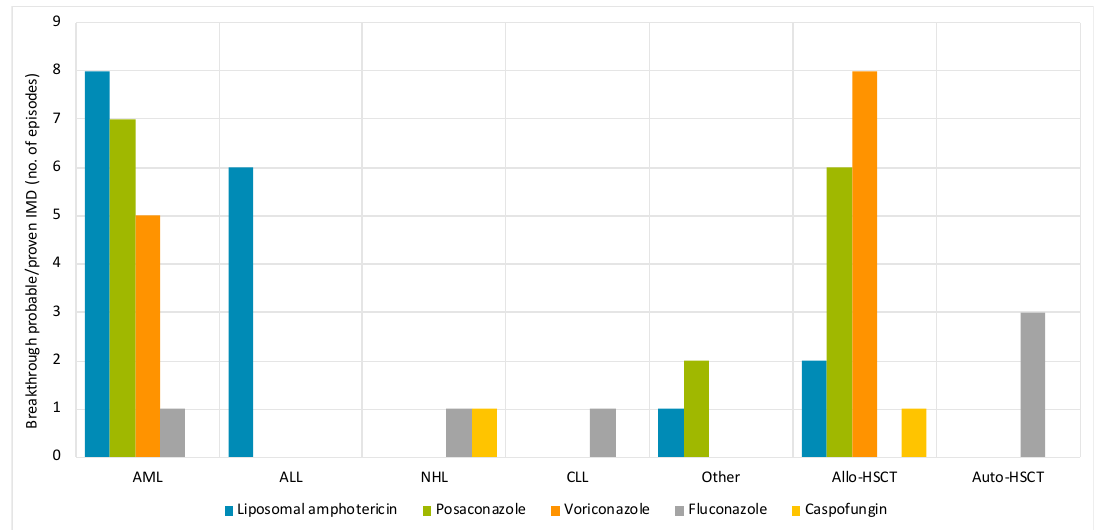
Figure 2. Breakthrough probable/proven IMD ( n = 53 episodes) on antifungal prophylaxis. Abbreviations: IMD, invasive mold disease; AML, acute myeloid leukemia; ALL, acute lymphoblastic leukemia; NHL, non-Hodgkin’s lymphoma; CLL, chronic lymphocytic leukemia; HSCT, hemopoietic stem cell transplant (allo-, allogeneic; auto-autologous). Other refers to primary blastic dendritic cell neoplasm, blastic plasmacytoid dendritic cell neoplasm, mixed phenotype acute leukemia.